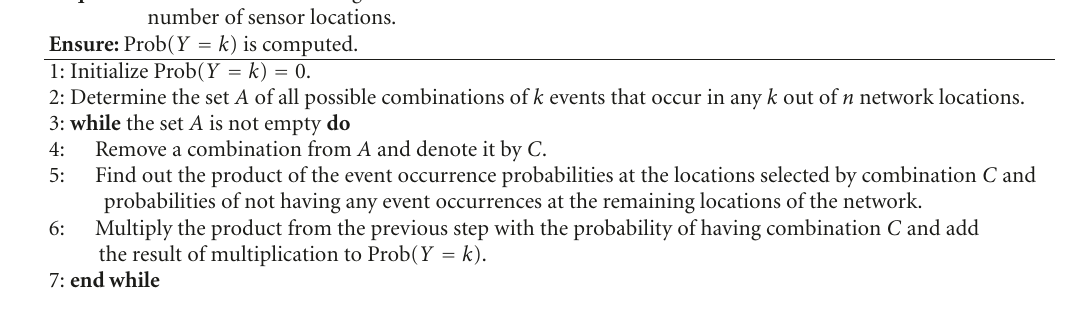
Algorithm 1: Probability computation for Y .